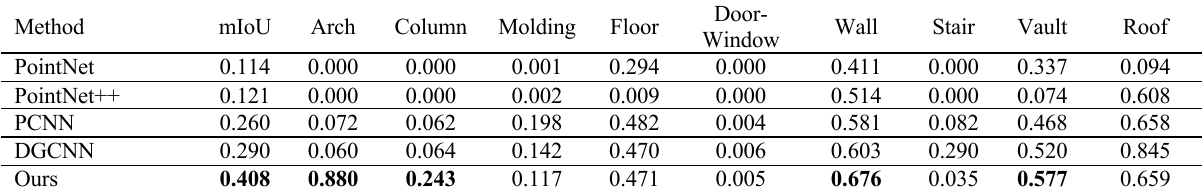
Table 2. Our per-class IoU and class-averaged mIoU results on Scene_B vs prior works on ArCH data set. Each column represents the IoU of the category it belongs. Our method performs better than others in many classes with only 3 scenes (about 10% of 10